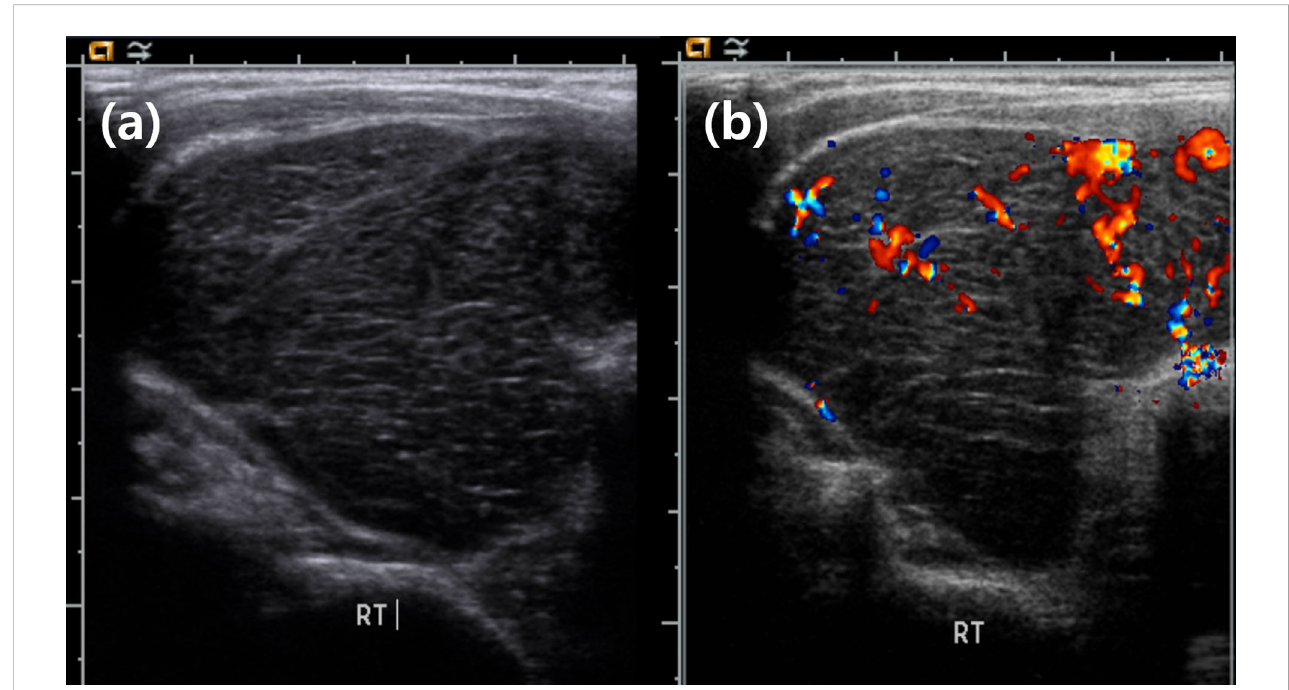
FIGURE 1 Ultrasound appearance of thyroid lymphoma. (A) Large solid mass with very hypoechoic feature. (B) Increased vascularity in